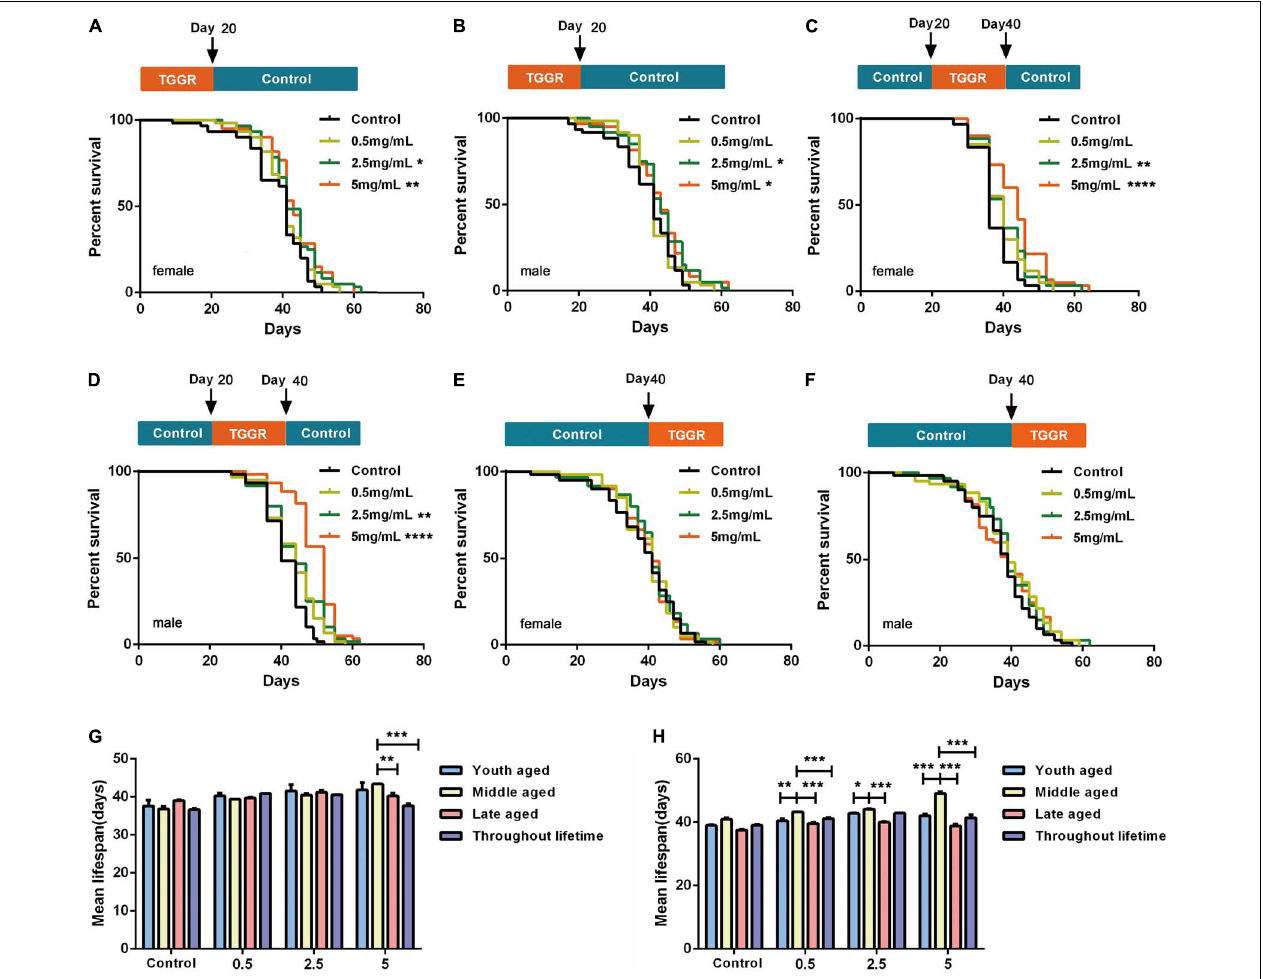
FIGURE 3 | TGGR effect on Drosophila longevity. Brief treatment with TGGR for 20 days early in adulthood extended the lifespan of female (A) and male (B) flies; TGGR extended the lifespan of 20-day-old female (C) and male (D) flies at concentrations from 0.5 to 5 mg/mL (at 40 days, medium was changed to sugar-yeast-agar); Treatment with TGGR for 20 days in late-aged flies (TGGR medium at 40–60 days) did not significantly extend the lifespan of female (E) or male (F) flies [ N = 120 flies per condition, Log-rank (Mantel-Cox) test]. Comparative analysis of the median lifespan of the four methods of administration in female (G) and male flies (H) ; between 0 and 20-day-old (young-aged) flies, between 20 and 40-day-old (middle-aged) flies, and between 40 to 60 days (late-aged) flies ( N = 120 flies per condition, two-way ANOVA). * p < 0.05, ** p < 0.01, *** p < 0.001, **** p < 0.0001 vs. the